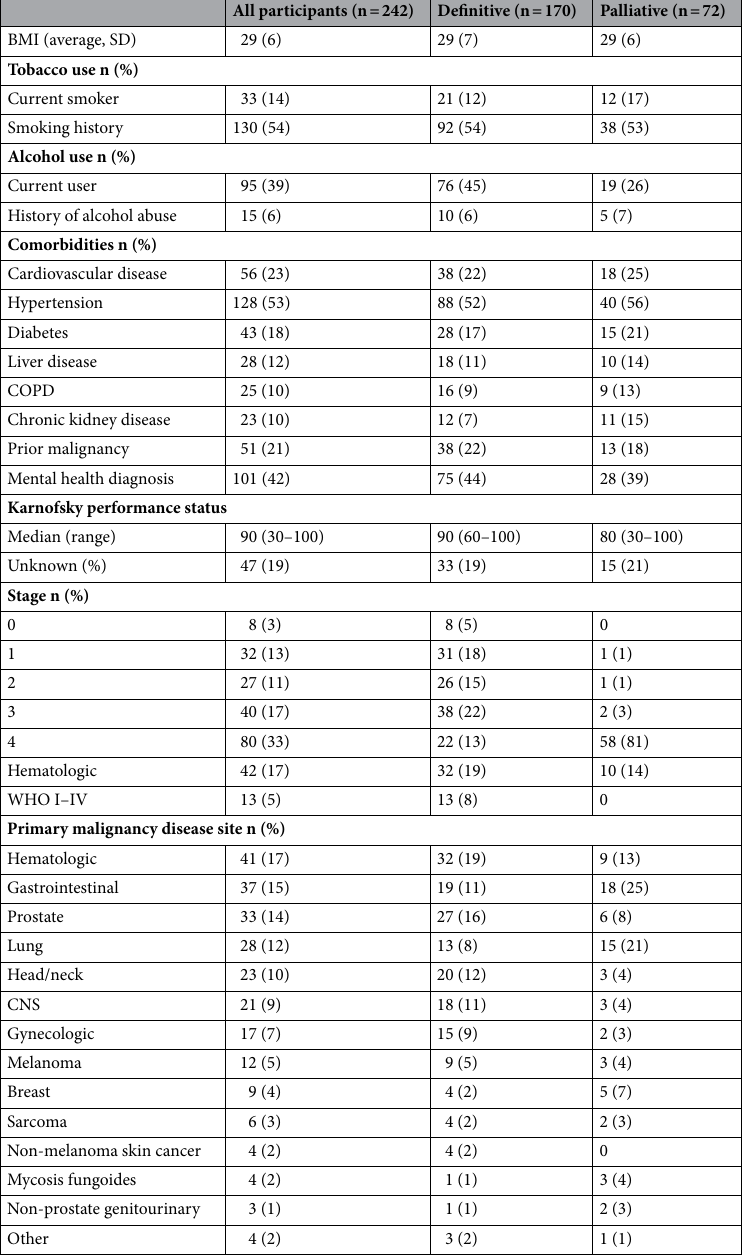
Table 2. Participant health information. BMI body mass index, SD standard deviation, COPD chronic obstructive pulmonary disease, WHO World Health Organization, CNS central nervous